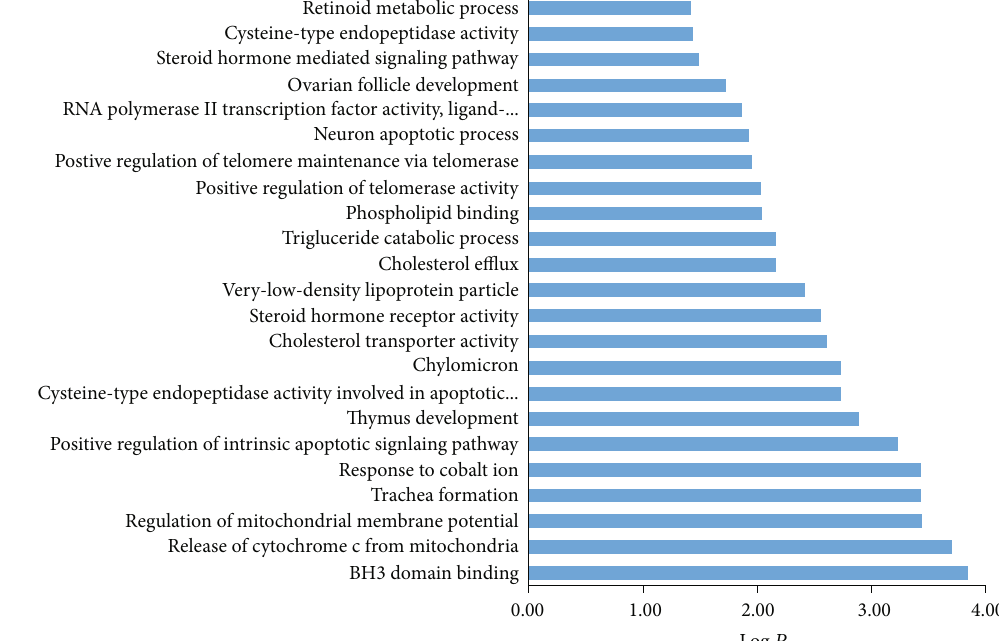
Figure 4: GO enrichment analysis of targets. The y -axis represents the biological process of the top 23 functional enrichment, and the x -axis represents the negative logarithm of P value.